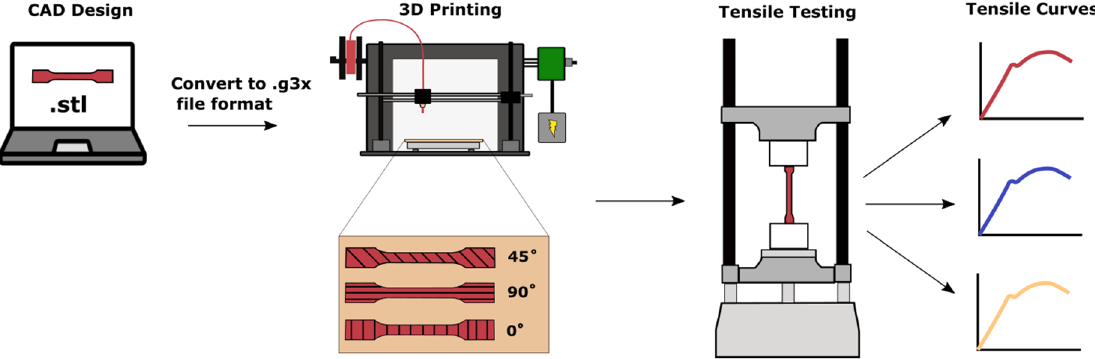
Figure 1. Schematic of overall procedure for 3D printing and mechanical testing of tensile specimens.